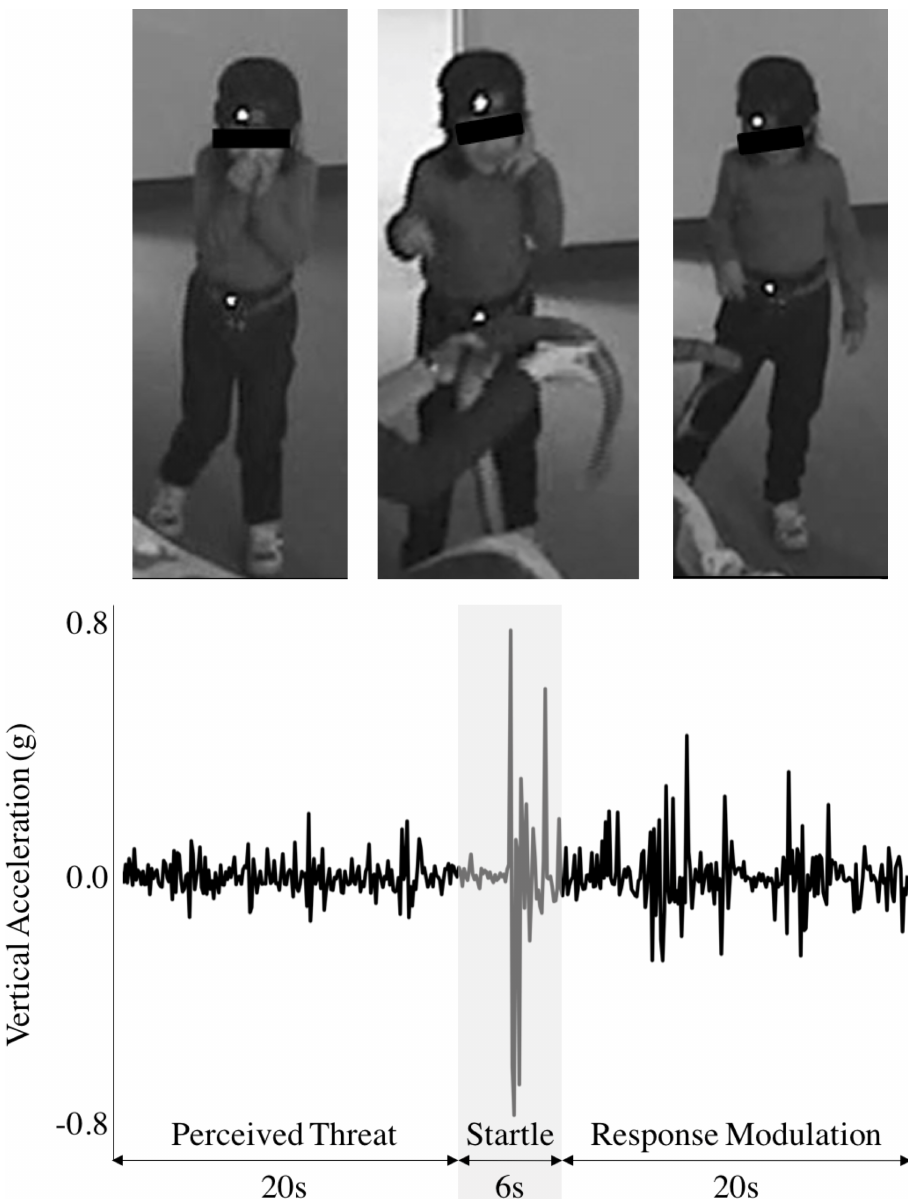
Fig 1. Vertical acceleration measured from waist-worn IMU during mood induction task. Potential threat, startle, and response modulation phases of the snake task (and corresponding images) are indicated for reference. The parent of individual in this figure has given written informed consent (as outlined in PLOS consent form) to publish this